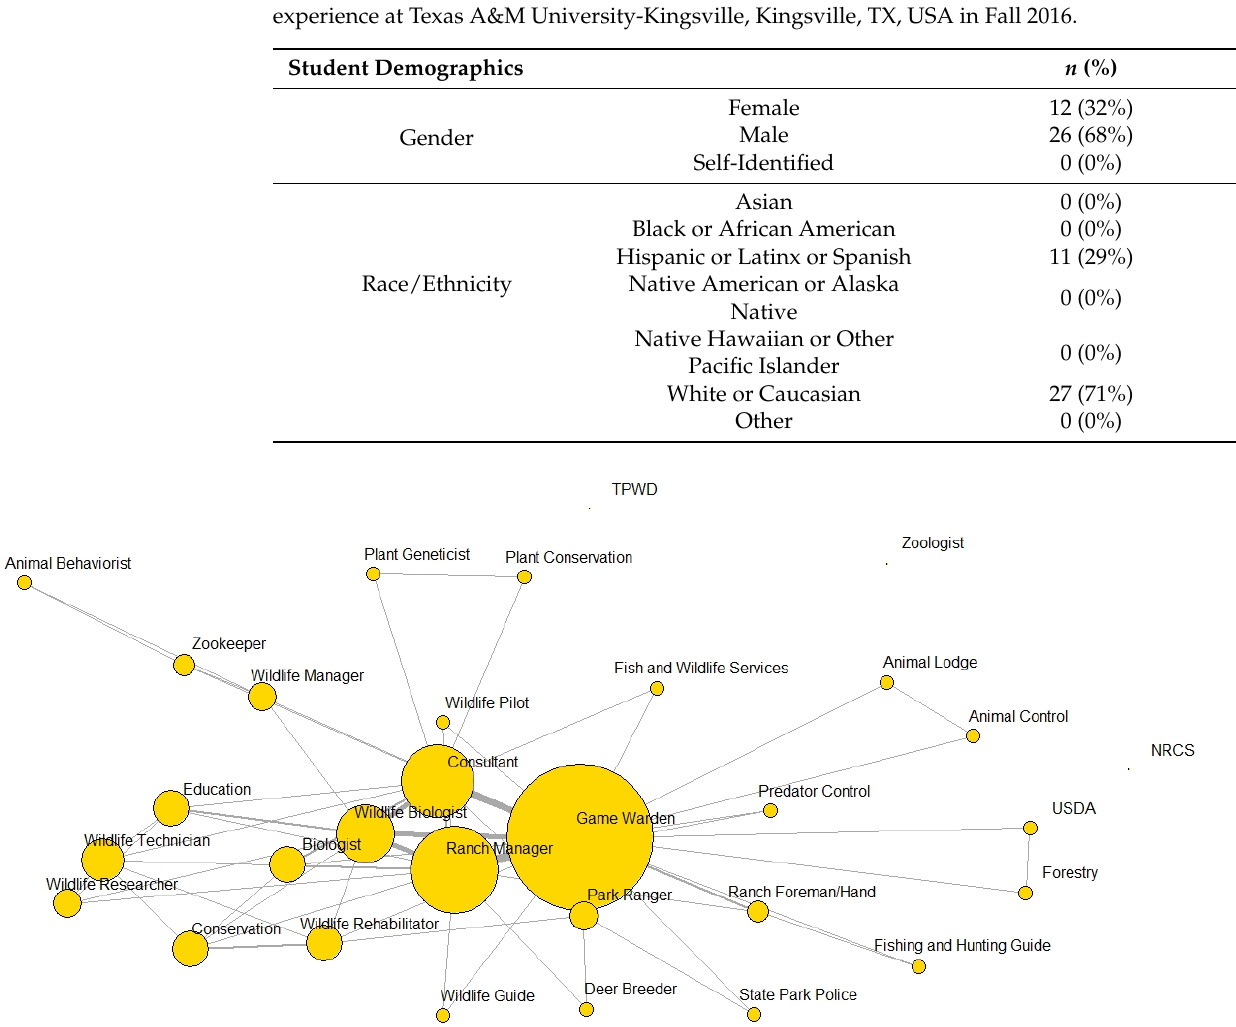
Figure 1. Network of career choices most reported (larger vertices) and co-occurrence of career choices (connecting lines) with bolder lines representing careers more frequently reported together